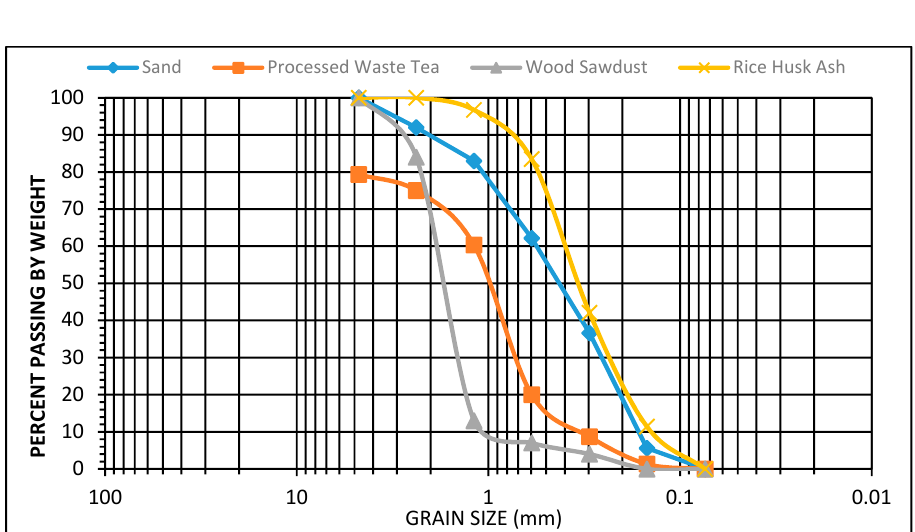
Figure 1. Fine aggregate sieve analysis.